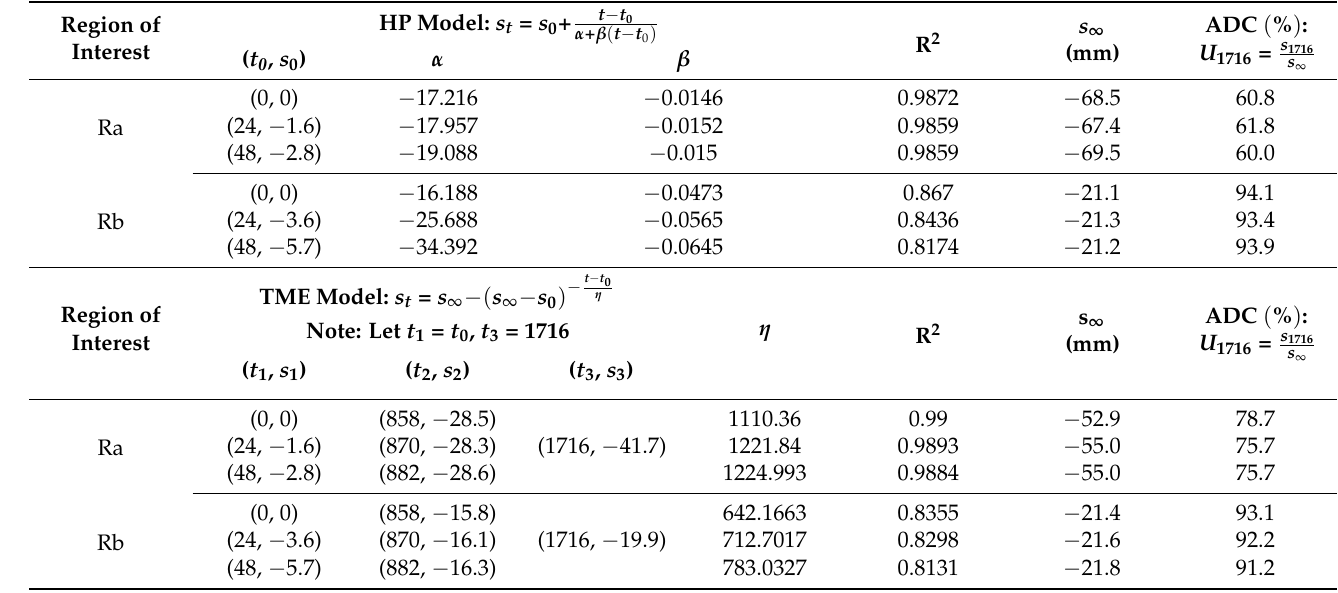
Table 1. Prediction results of hyperbolic (HP) model and three-point modified exponential (TME) model. α , β and η are undetermined